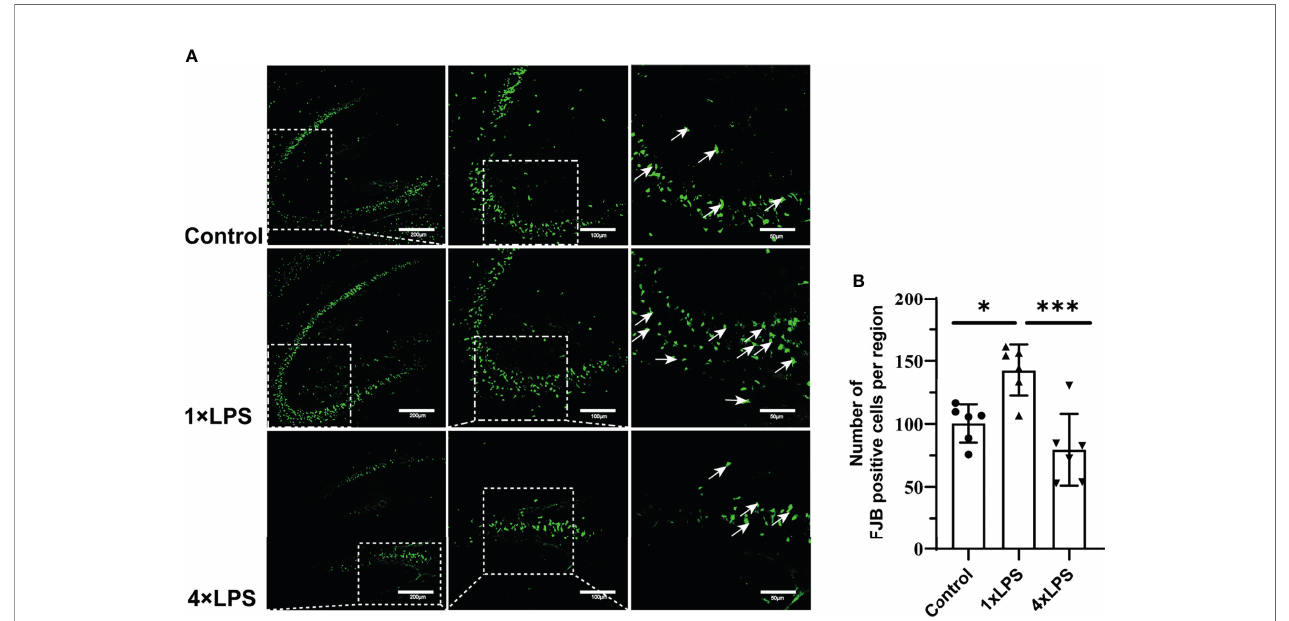
FIGURE 6 | | Immune tolerance alleviates neuronal degeneration after epilepsy. (A) FJB positive neurons (green; Alexa Fluor-488 staining) in hippocampus were observed with fl uorescence microscope 24 hours after epilepsy modeling. White arrows indicate FJB positive neurons. Scale bars: 200 µm for 100×, 100 µm for 200×, 50 µm for 400×. (B) Quantitative statistics of FJB-positive cell number. Data are expressed as the mean ± SEM (n = 3 per group). *P < 0.05; ***p < 0.001 by one-way ANOVA (and nonparametric or mixed) followed by methods of multiple comparisons. FJB: Fluoro-Jade